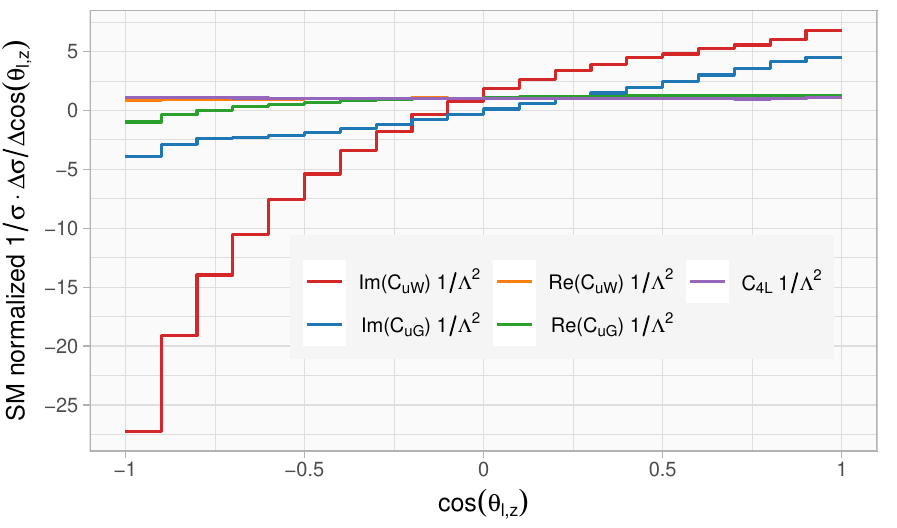
Figure 20. To itself and to the SM normalized SMEFT contributions to the cos (cid:18) l;y distribution at NLO in QCD . Results are presented for the real and imaginary parts of C 33 as for the four quark operator C 4 L .